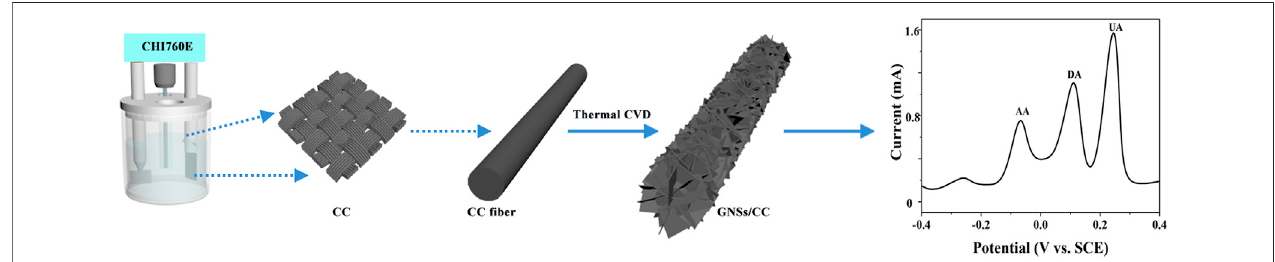
FIGURE 1 | Schematic diagram of the fabrication process of the GNSs/CC sensor and the simultaneous detection of three small molecules (AA, DA, and